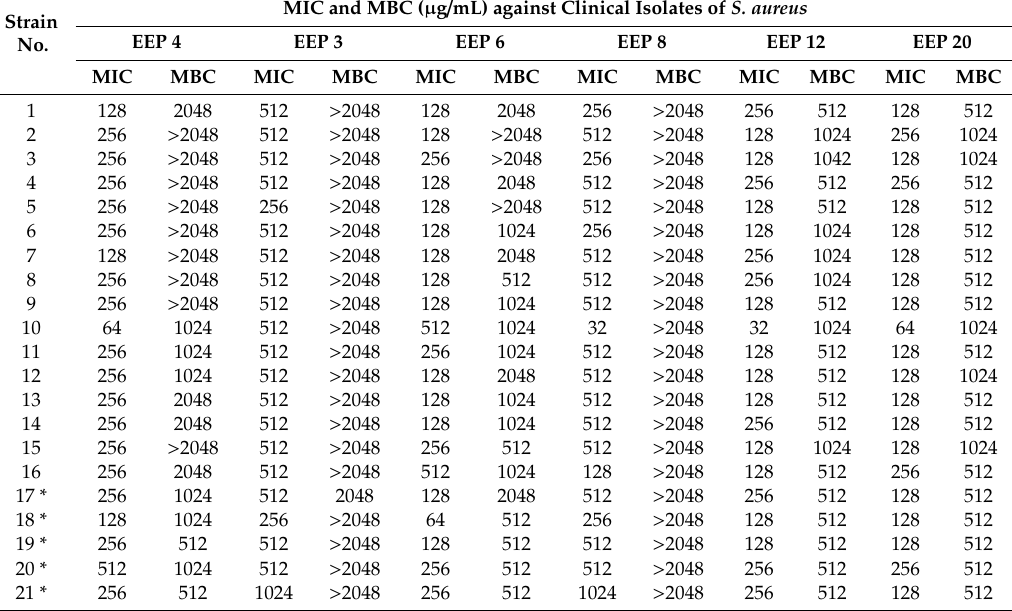
Table 2. Antibacterial activity of selected ethanolic extracts of propolis collected from Polish apiaries against clinical isolates of S. aureus (MSSA and MRSA). Strain